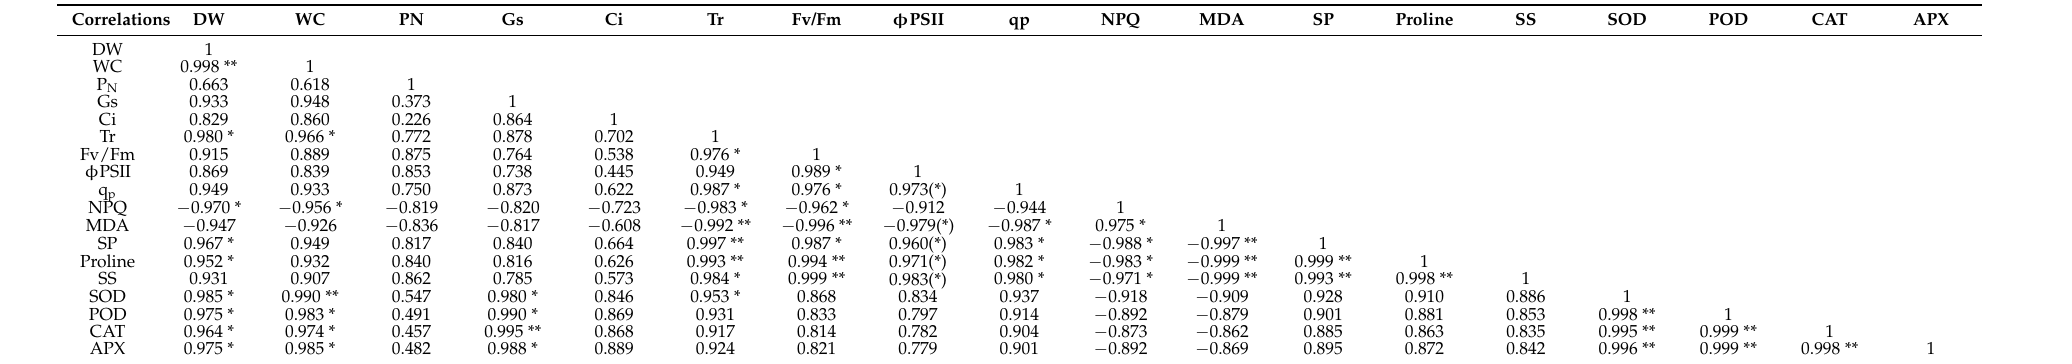
Table A4. Correlation analysis of physiological indexes under drought stress lasting for 15 days